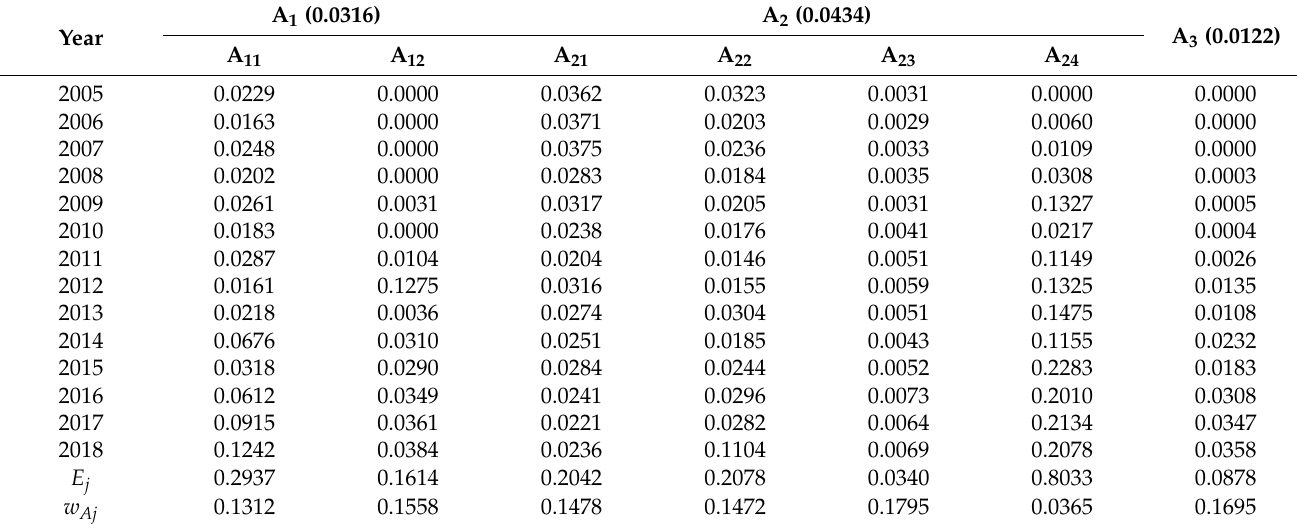
Table 2. Information entropy and weight of each indicator of